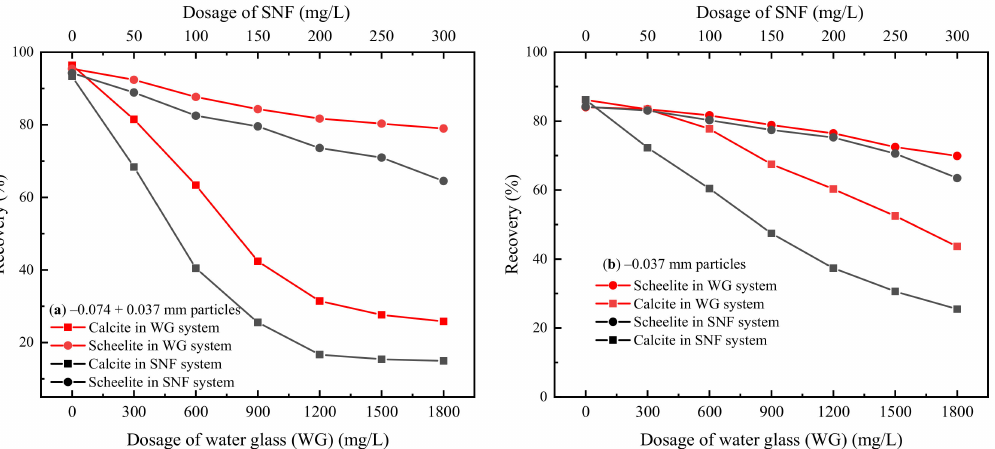
Figure 4. Effects of the depressant dosage on the floatabilities of scheelite and calcite with size fractions of − 0.074 + 0.037 mm ( a ) and − 0.037 mm ( b ) (C NaOL = 50 mg/L, pH ≈